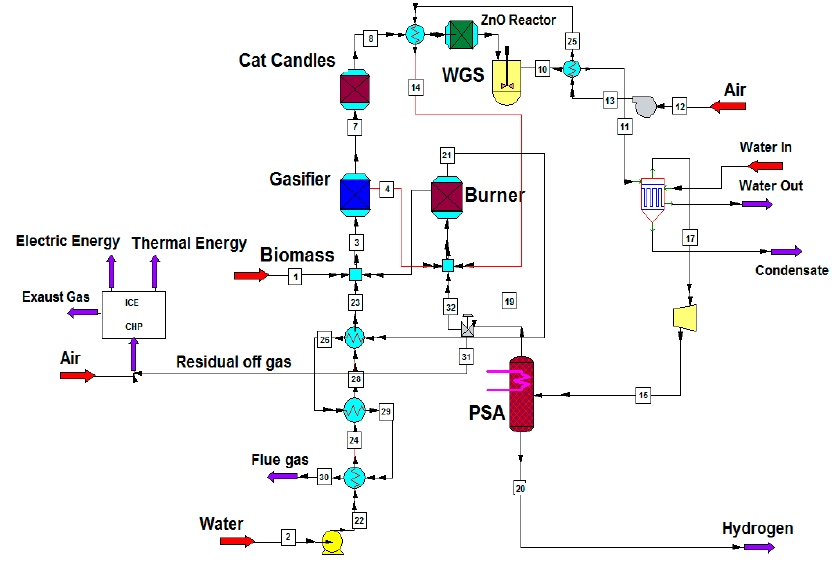
Figure 1. Flow sheet of the plant evaluated in this study.